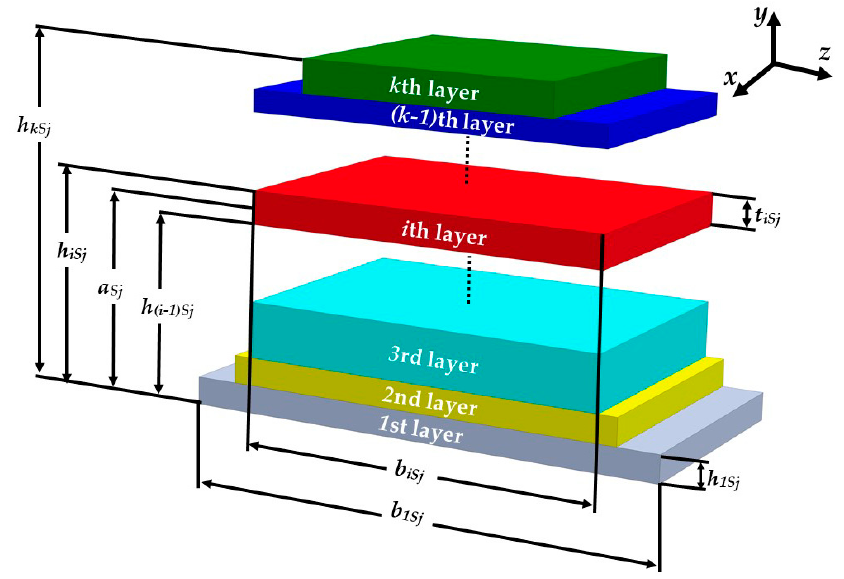
Figure 5. View of the nomenclature used to determine the elastic centroid ( a sj ) of the j th cross-section of pVEH microdevice equivalent resonator.